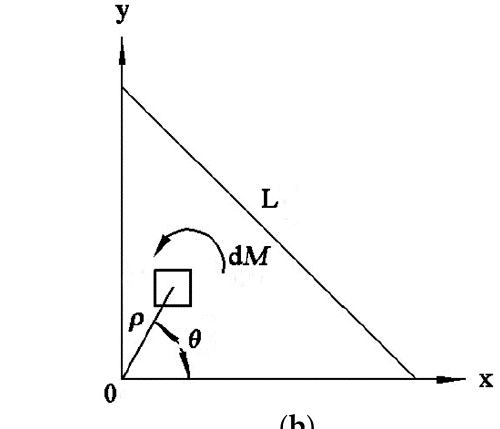
Figure 14. Principle of the analytical model: ( a ) position of the icing sample in the Cartesian coordinates; ( b ) a quarter of the icing sample. As shown in Figure 14a, because the shape of the iced aluminum alloy is square, for simplifying the process of modeling, the diagonals of the iced aluminum alloy plate